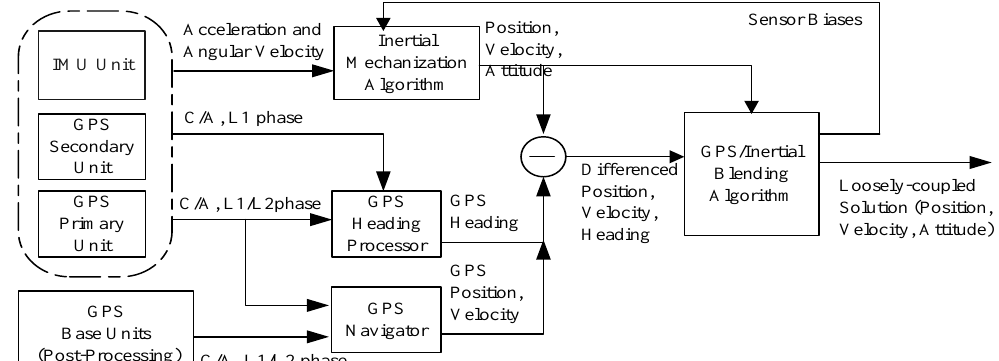
Figure 4. Loosely-coupled Global Position System (GPS)-aided inertial navigation